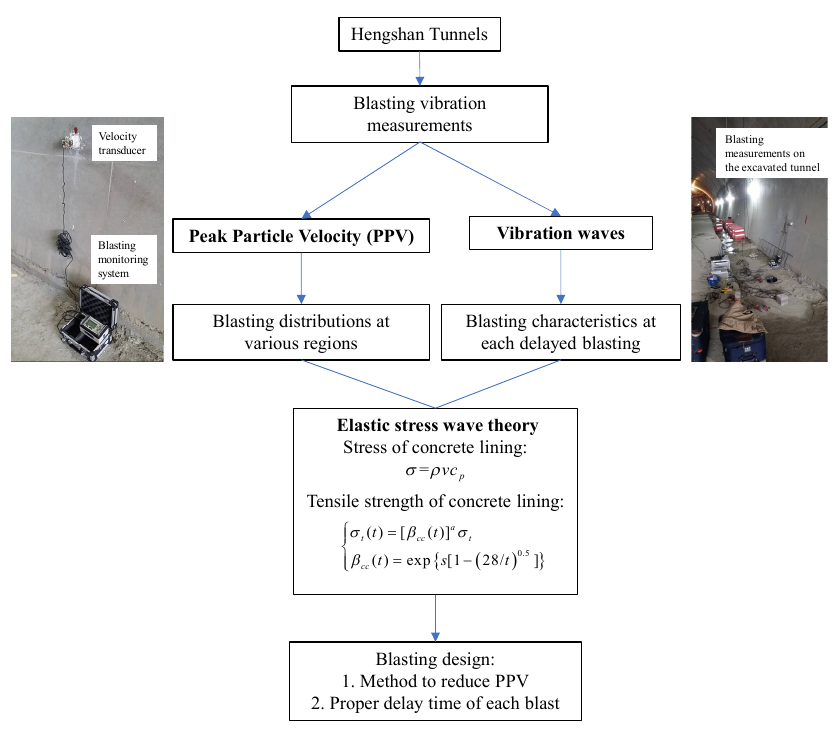
Figure 1. Research framework.